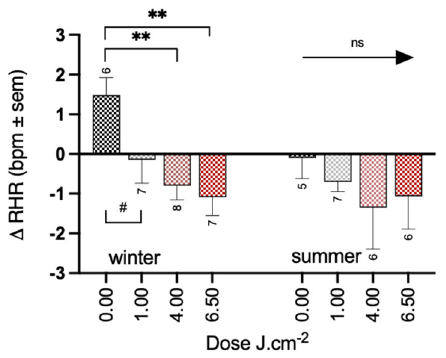
Figure 7. Short-term effects of PBM treatment (average between one stimulation and baseline and two stimulations and baseline) on resting heart rate for summer and winter separately. Significance codes: ** p < 0.01, # p < 0.1, ns: not significant.